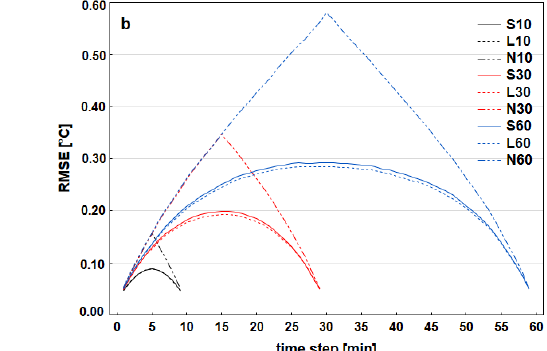
Figure 3. Comparison of accuracy of bilinear interpolation of 1-min air temperature data from 5-, 10-, 15-, 20-, 30-, 45- and 60-min time intervals on meteorological stations Zby, Rou and Hos.